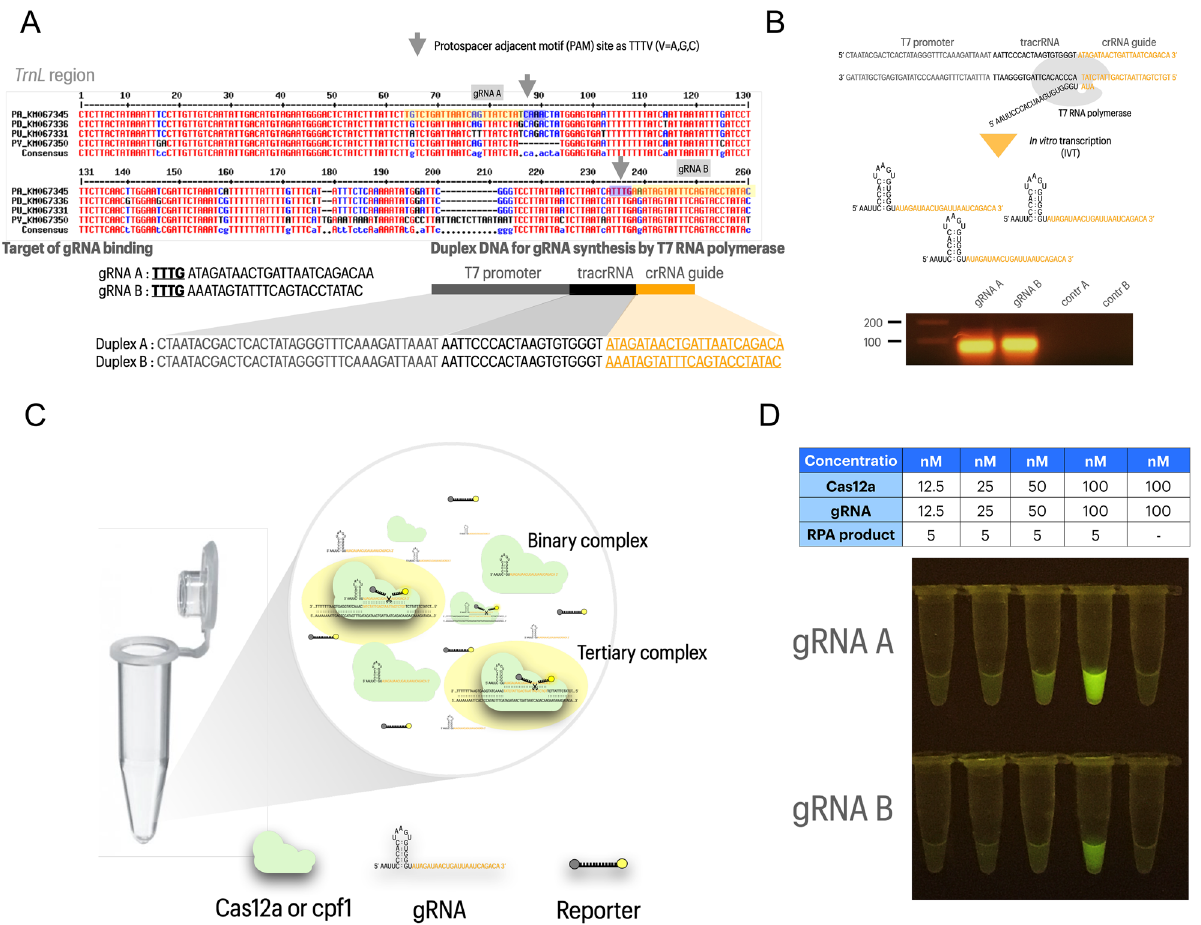
Figure 1. The preparation of cas12a condition for species authentication. ( A ) gRNA-A and gRNA-B design based on the multiple alignment of trnL loci and the construction of double stranded DNA as temples for gRNA synthesis. ( B ) The synthesis of gRNA-A and gRNA-B by in vitro transcription with T7 RNA polymerase and the synthesized gRNAs were detected by agarose gel electrophoresis. ( C ) The schematic illustrates the mechanism of cas12a to form binary and tertiary complex to cleave the reporter single stranded DNA as result of the fluorescence signal. ( D ) The condition optimization of in vitro digestion of cas12a by varying the concentration ratio of cas12a and gRNA at 1: 1 to produce the fluorescence at 37 °C for an hour. Phyllanthus species were studied including Phyllanthus amarus (PA), Phyllanthus urinaria (PU), Phyllanthus debilis (PD), Phyllanthus virgatus (PV). Initial image of agarose gel electrophoresis is shown in Figure